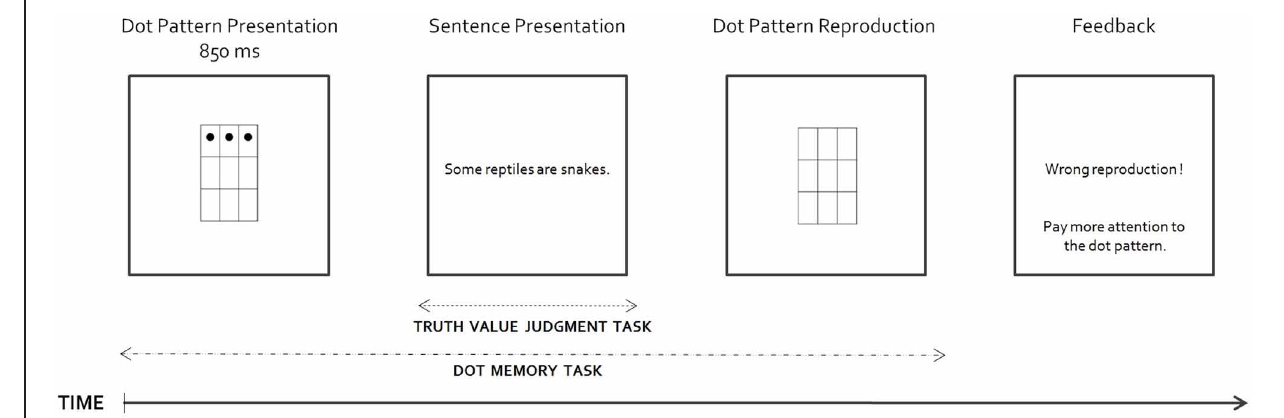
FIGURE 2 | General structure of a trial.